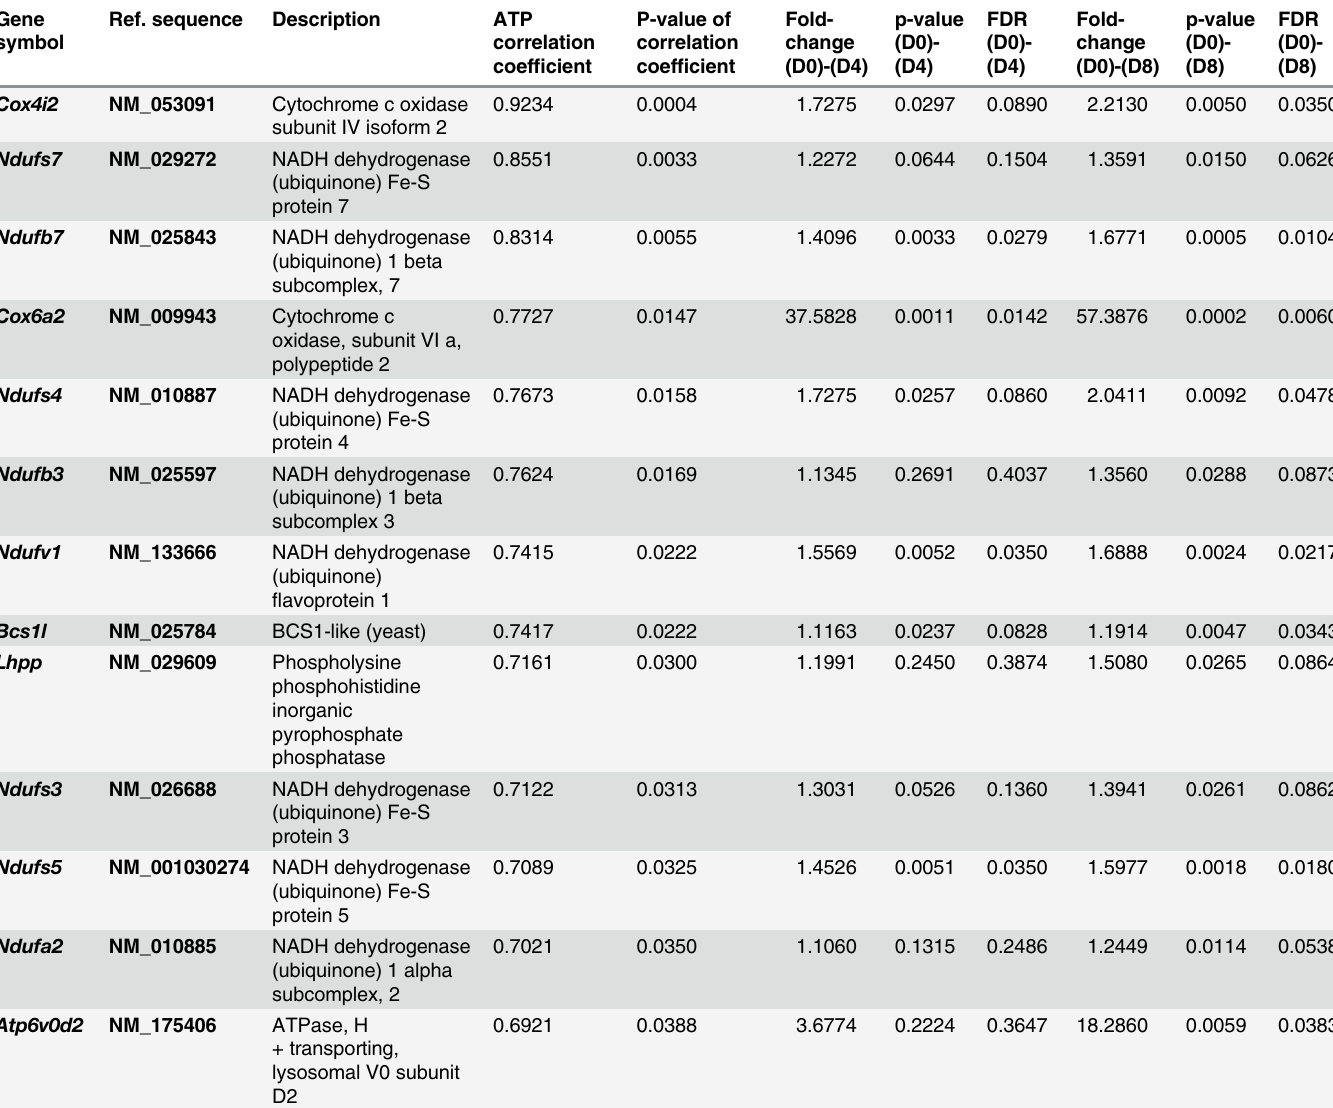
Table 1. List of differentially-expressed genes affecting ATP level during myogenic differentiation in C2C12 cells. Gene Ref. symbol